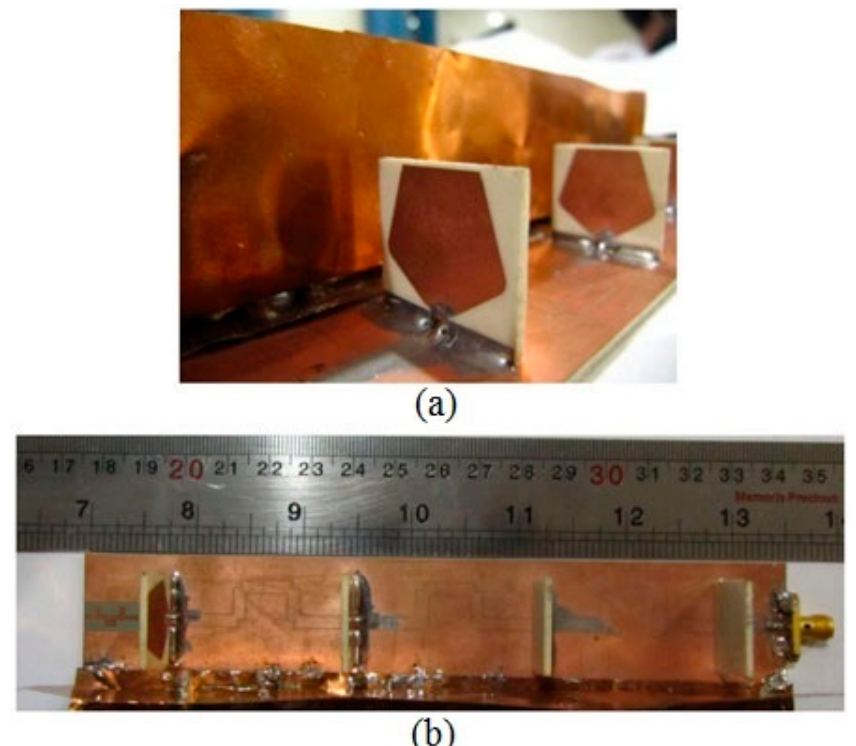
Figure 13. Fabricated Picture of the Bandwidth-Enhanced Frequency Scanning Fan Beam Array Antenna with bandpass filter integrated into the feedline ( a ) Perspective view; ( b ) Top view.